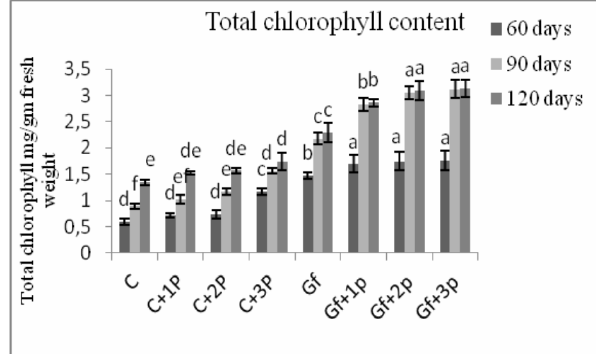
Fig. 1. The percentage of AM colonization in Catharanthus ro- seus L. after 60, 90 and 120 days of AM inoculation